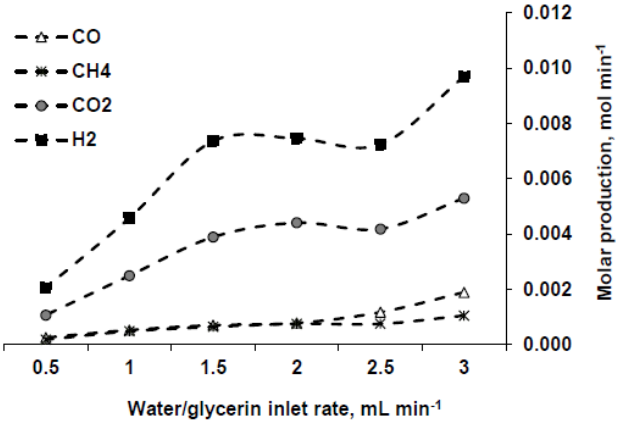
Figure 3. Evolution of gases with inlet flow rate. Water/glycerin ratio: 9/1. Temperature: 900 °C. From the experimental data, the values of H 2 molar fraction, highest heating value of the gas (HHV, kJ ∙ N ∙ m − 3 ), derived power (kJ ∙ min − 1 ), and energy (kJ) per mL of glycerin, were calculated and